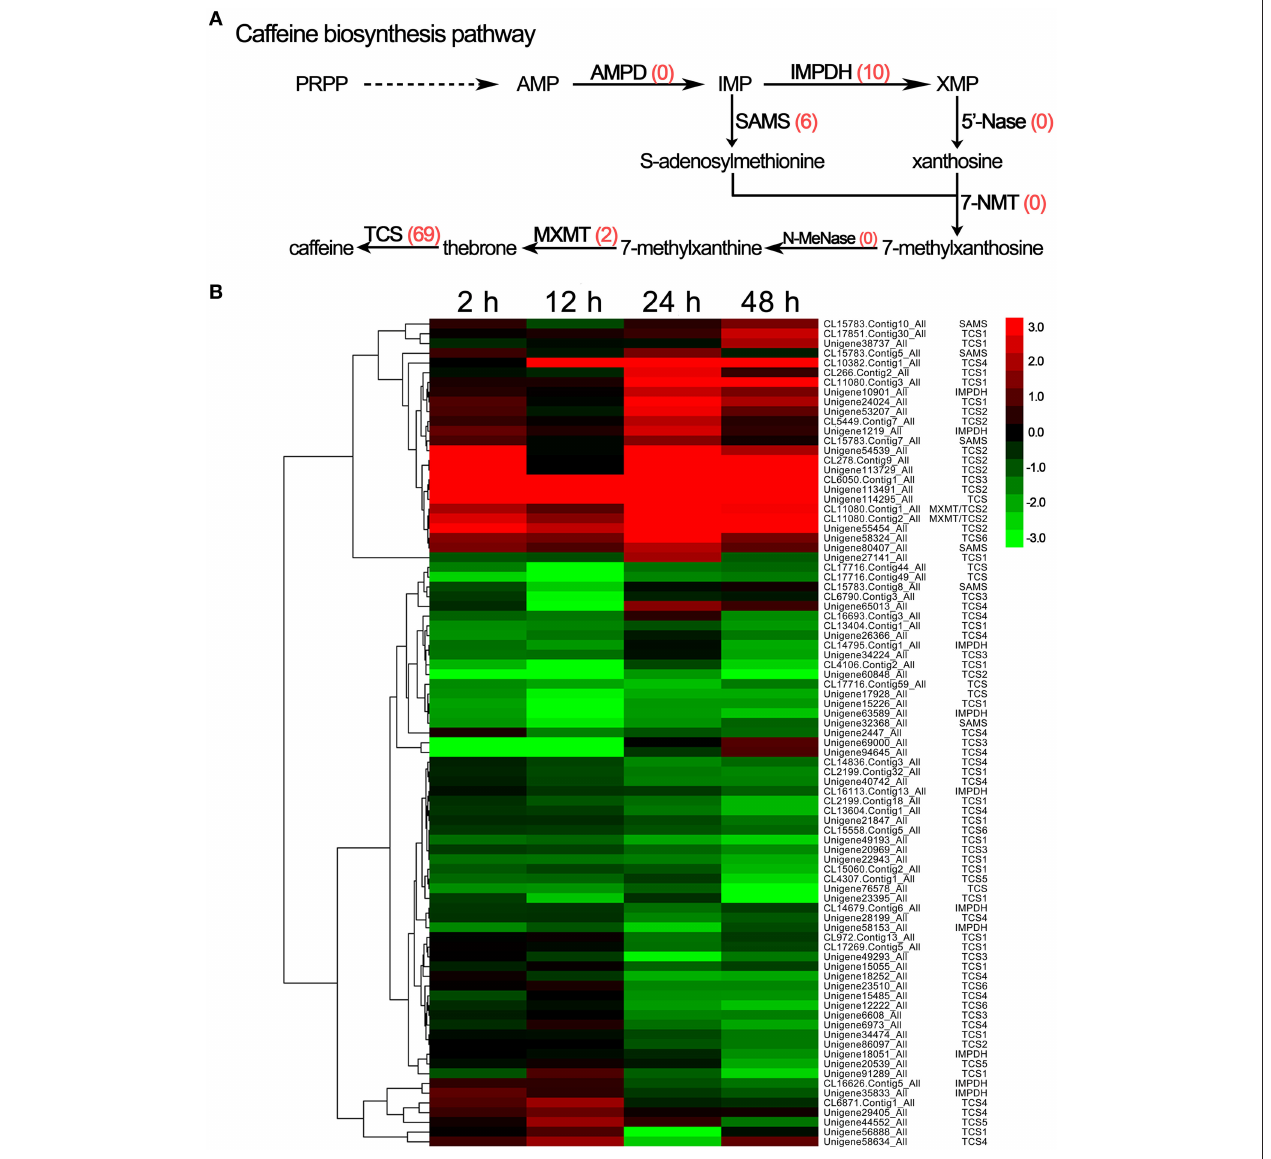
FIGURE 6 | DEGs involved in caffeine biosynthesis in C. sinensis leaves under drought stress. (A) The caffeine biosynthesis pathway. The red numbers in parentheses following each gene name indicate the number of corresponding DEGs. AMPD, AMP deaminase; IMPDH, IMP dehydrogenase; 5 ′ -Nase, 5 ′ -nucleotidase; SAMS, S-adenosylmethionine synthase; 7-NMT, 7-methylxanthosine synthase; N-MeNase, N-methylnucleotidase; MXMT, theobromine synthase; TCS, tea caffeine synthase. (B) Hierarchical clustering analysis of the relative expression levels of the DEGs related to caffeine biosynthetic. The FPKM ratio of unigene expression is represented on a logarithmic scale for each treatment period (2, 12, 24, or 48h) and the control (0h). Red indicates that a gene was up-regulated at that stage, whereas green indicates down-regulated